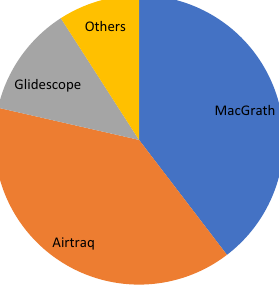
Fig. 1 Distribution of videolaryngoscope in French ICUs